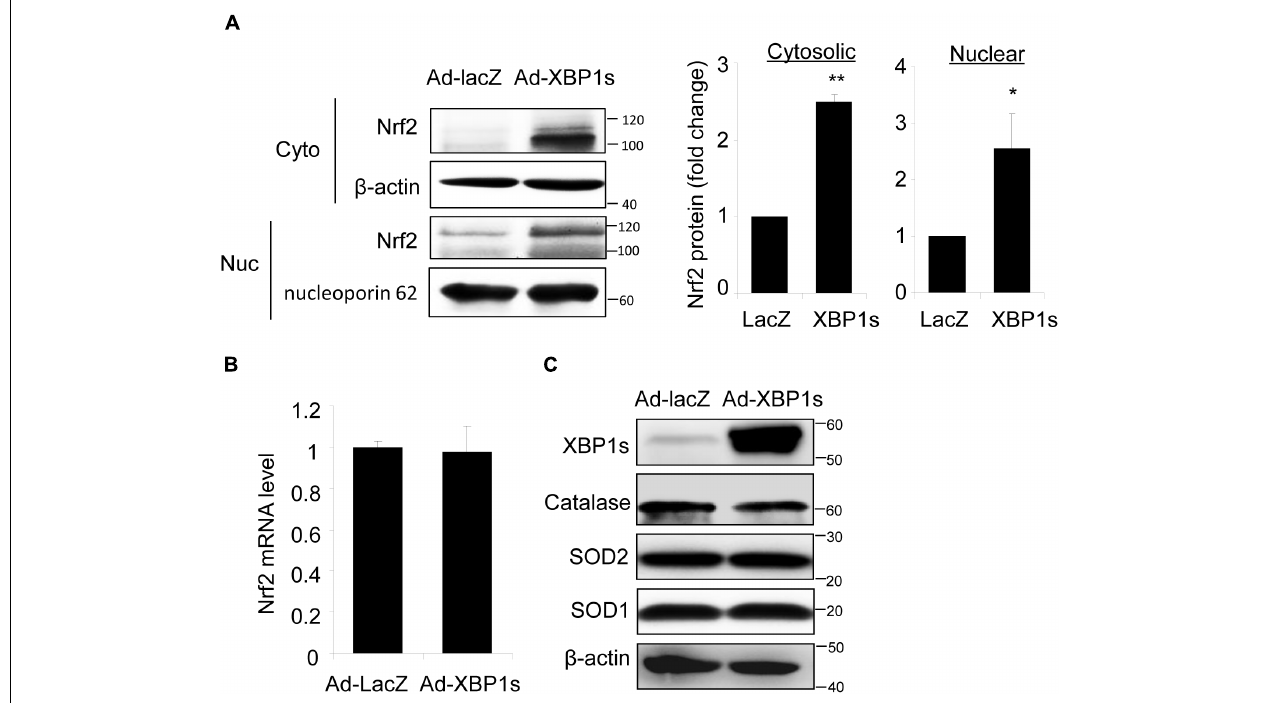
FIGURE 3 | Overexpression of Spliced XBP1 increased Nrf2 protein level in ARPE-19 cells. ARPE-19 cells were transfected with adenovirus overexpressing spliced XBP1 . (A) Nrf2 expression in the cytosol and nucleus was measured separately by Western blot and semi-quantified by densitometry (mean ± SD, n = 3, ∗ p < 0.05, ∗∗ p < 0.01). (B) Nrf2 mRNA level was detected by real-time PCR (mean ± SD, n = 3). (C) Protein levels of XBP1, Catalase, SOD2, and SOD1 in whole cell lysate were detected by Western blot